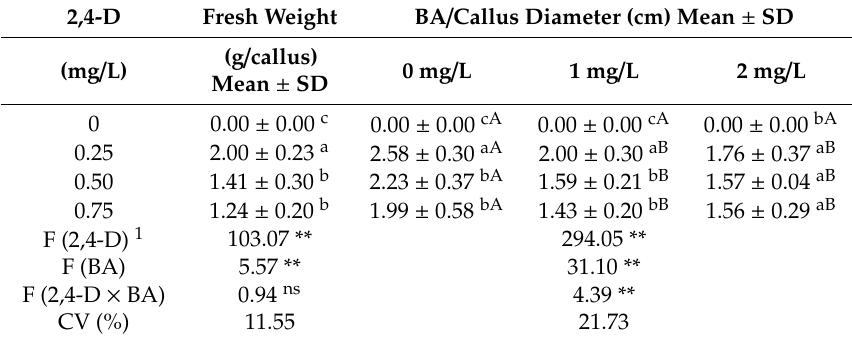
1 Each mean represents 10 replicates (test tubes) with one nodal segment each. Means within a column (2,4-D e ff ects; lowercase) or lines (BA e ff ects; uppercase) followed by di ff erent letters are significantly di ff erent according to the Scott-Knot test at 1% (**) level of probability. All data followed a normal distribution according to the Shapiro-Wilk test. SD = standard deviation of means; F = distribution of variances according the F test; CV = coe ffi cient of variation; ns = not significant.